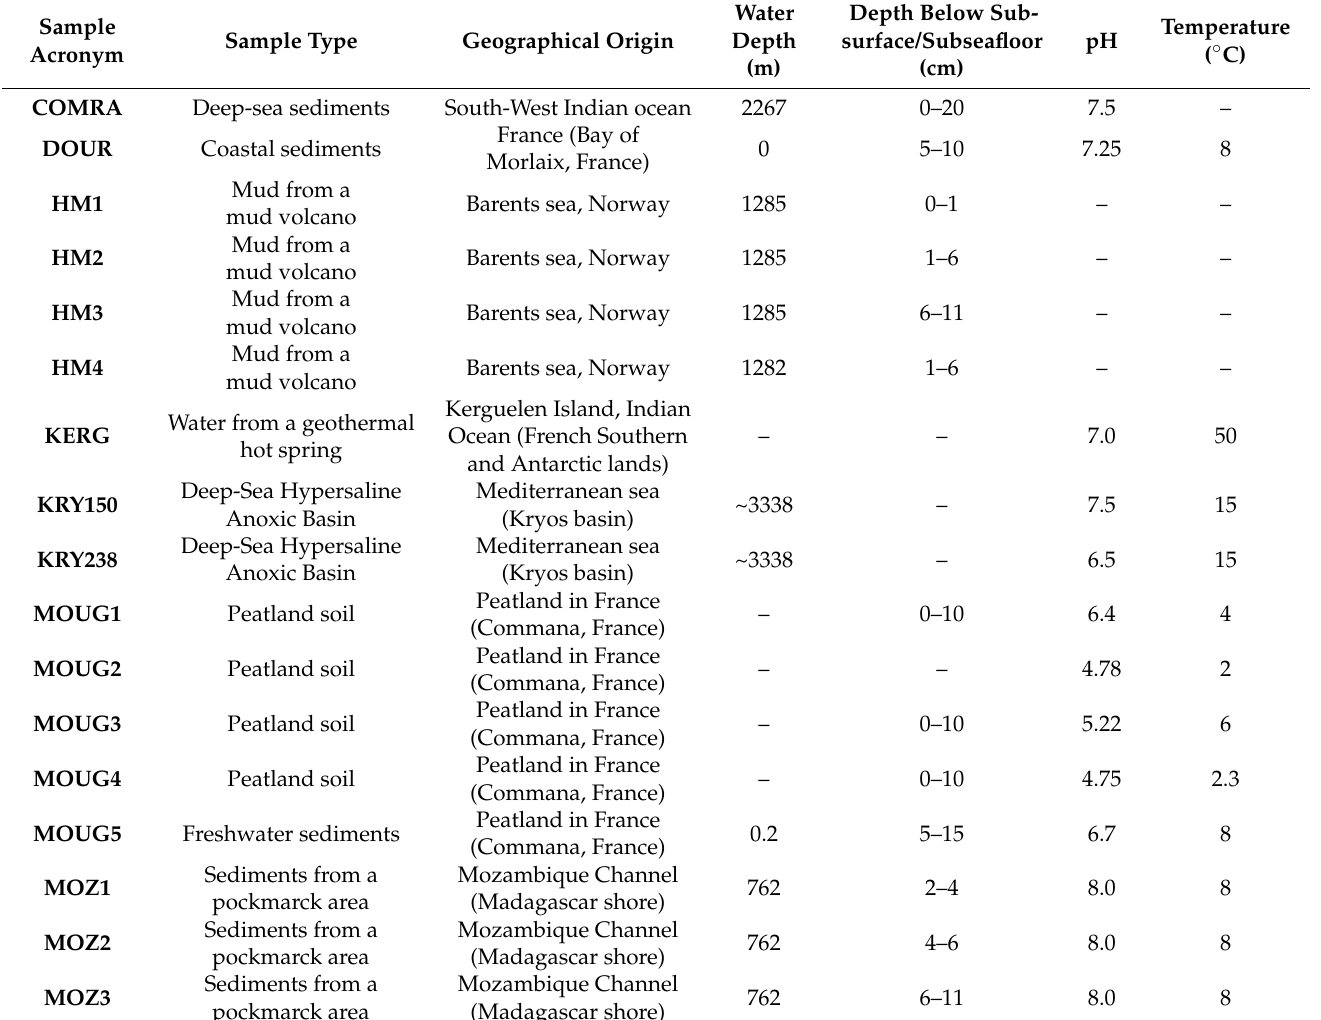
Table 1. Origin and main characteristics of the environmental samples selected after a pre-screening molecular stage target- ing Methanomassiliicoccales . Environmental parameters were measured in situ during cruises/expeditions. –, not